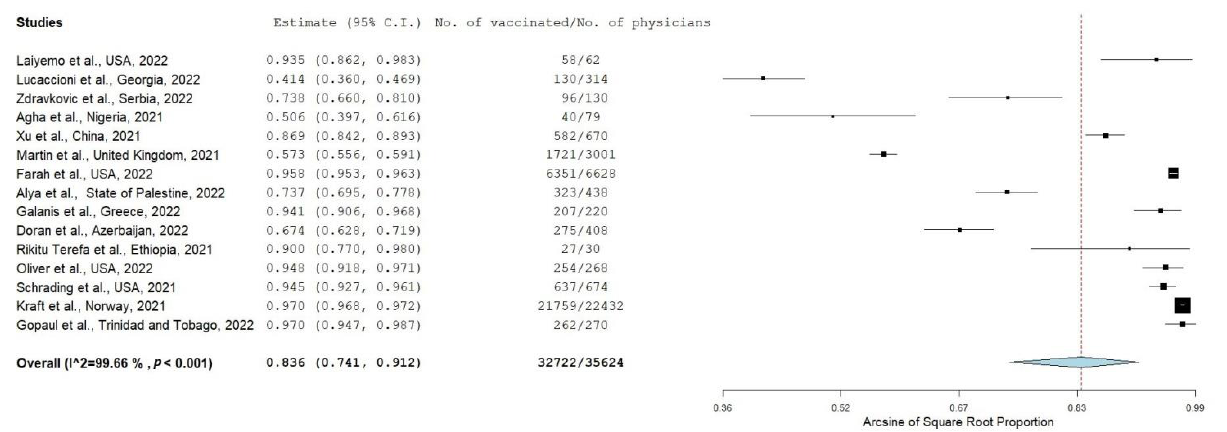
Figure 4. Forest plot of nurses vaccinated against COVID-19. [32,34,37,43–45,48,49,52,53,55] .